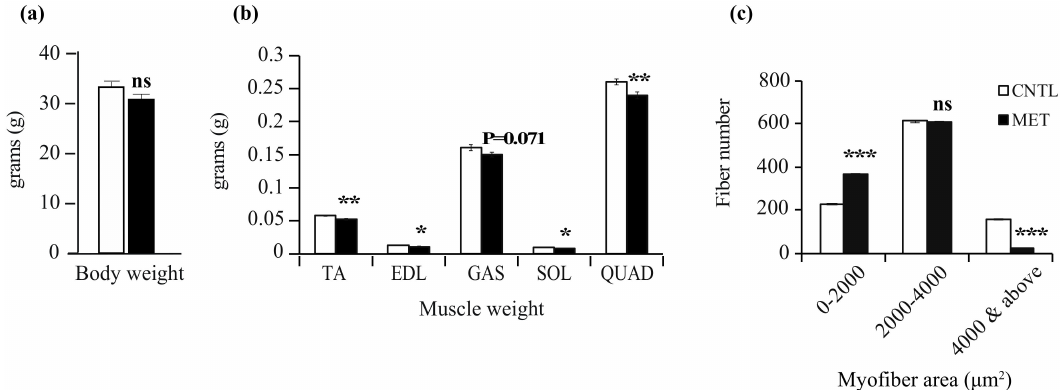
Figure 2. Metronidazole causes reduced hind limb muscle weight and myofiber surface area. ( a ) Metronidazole treatment of SPF mice resulted in a marginal, nonsignificant decrease in body weight compared to nontreated controls. N = 5 mice per group. ( b ) Absolute hind limb